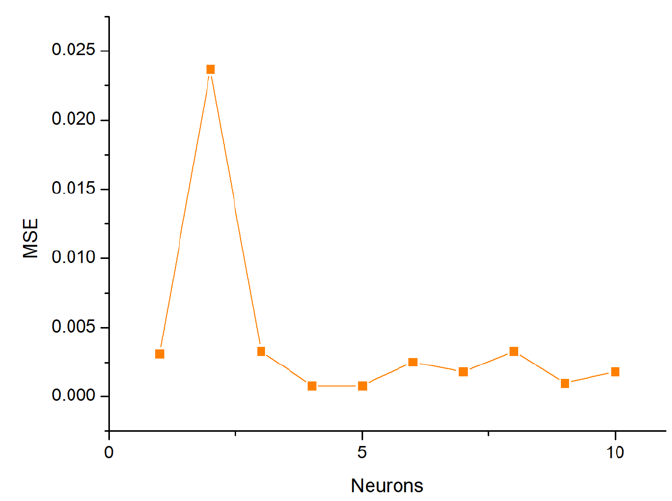
Figure 19. The experimental and predicted data of normalized decontamination.